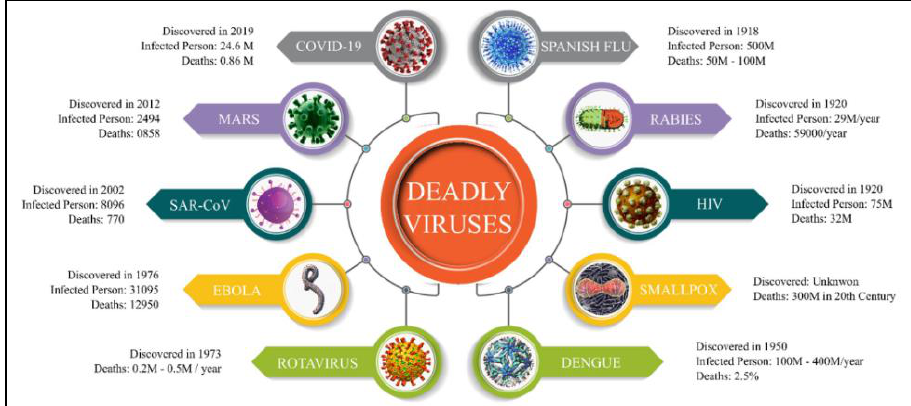
Figure 2. Deadliest Pandemics over the last 102 years (as of 25 August 2021).